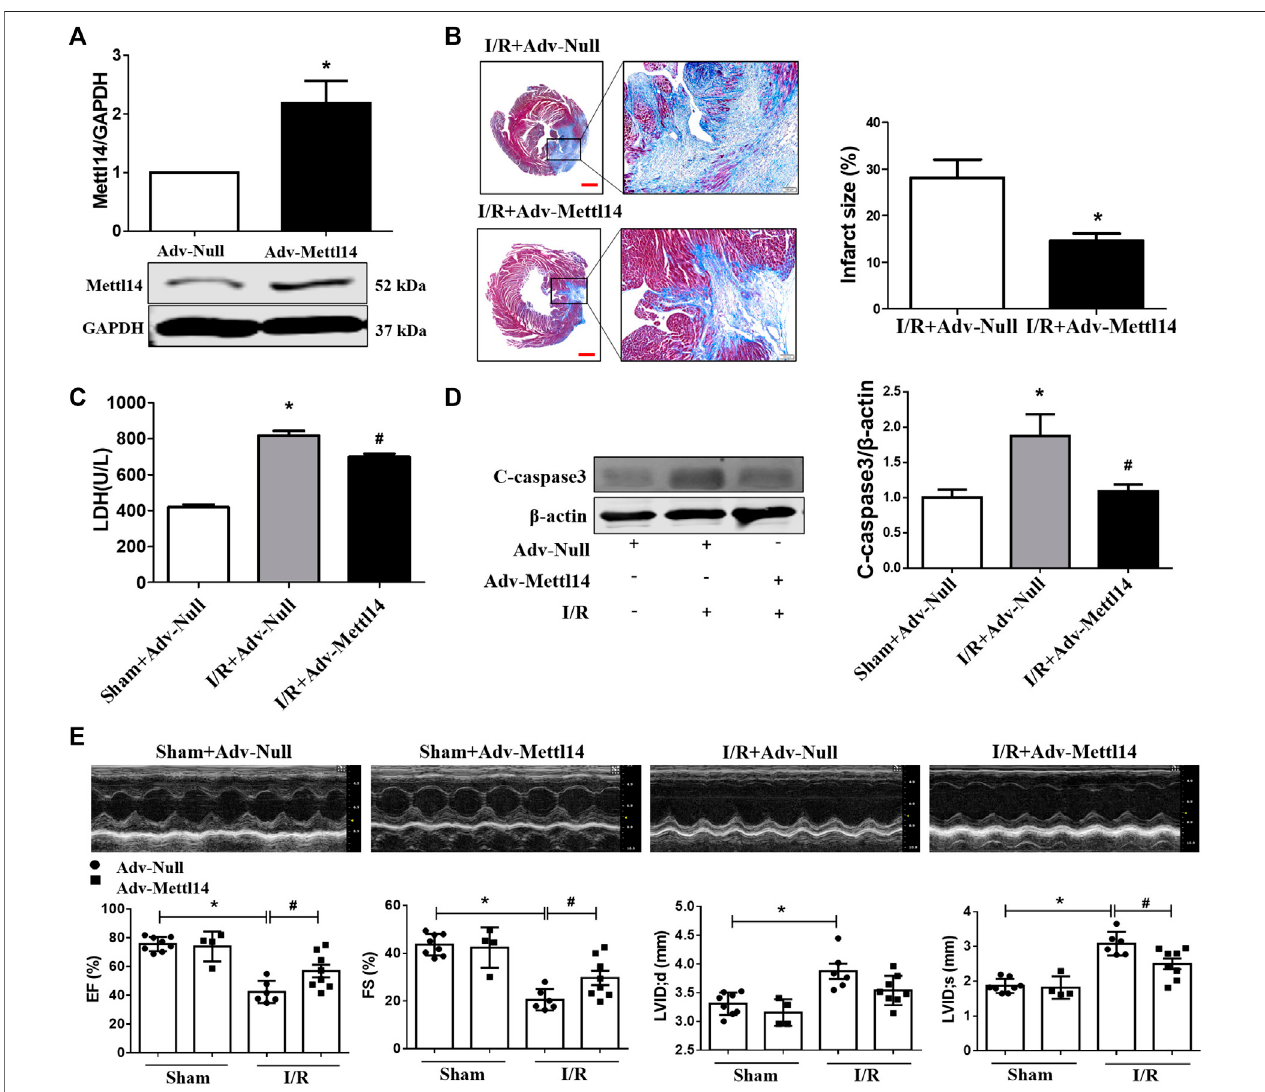
FIGURE3| Mettl14attenuates myocardial injury upon I/R. (A) Mouse heartswere infected byadenovirus.Theinfected mice weretreatedtoI/R or sham operation for 4 weeks. The expression of Mettl14 was analyzed by Western blotting. Adv-Null n (cid:2) 3, Adv-Mettl14 n (cid:2) 4. * p < 0.05 versus Adv-Null. (B) Infarct scar of I/R-4 week hearts was treated by Masson ’ s trichrome, bar (cid:2) 500 µm (left), scar bar (cid:2) 100 µm (right). Midline length measurement (Takagawa et al., 2007) was used to determine infarctscar. n (cid:2) 5mice pergroup.* p < 0.05versusI/R+Adv-Null. (C) PlasmaLDHactivity wasanalyzed bylactatedehydrogenaseassaykit.Sham+Adv-Null n (cid:2) 4, I/R+Adv-Null n (cid:2) 4, I/R+Adv-Mettl14 n (cid:2) 3. * p < 0.05 versus sham+Adv-Null. # p < 0.05 versus I/R+Adv-Null. (D) The cleaved caspase-3 expression was analyzed by Western blotting. n (cid:2) 4 mice per group. * p < 0.05 versus Sham+Adv-Null. # p < 0.05 versus I/R+Adv-Null. (E) Representative images of echocardiographs and statistics of ejection fraction (EF), fractional shortening (FS), left ventricular internal dimension at systole (LVIDs), and left ventricular internal dimension at end-diastole (LVIDd). Sham+Adv-Null n (cid:2) 8, sham+Adv-Mettl14 n (cid:2) 4, I/R+Adv-Null n (cid:2) 6, I/R+Adv-Mettl14 n (cid:2) 8. * p < 0.05 versus sham+Adv-Null. # p < 0.05 versus I/R+Adv-Null. Data are represented as mean ±